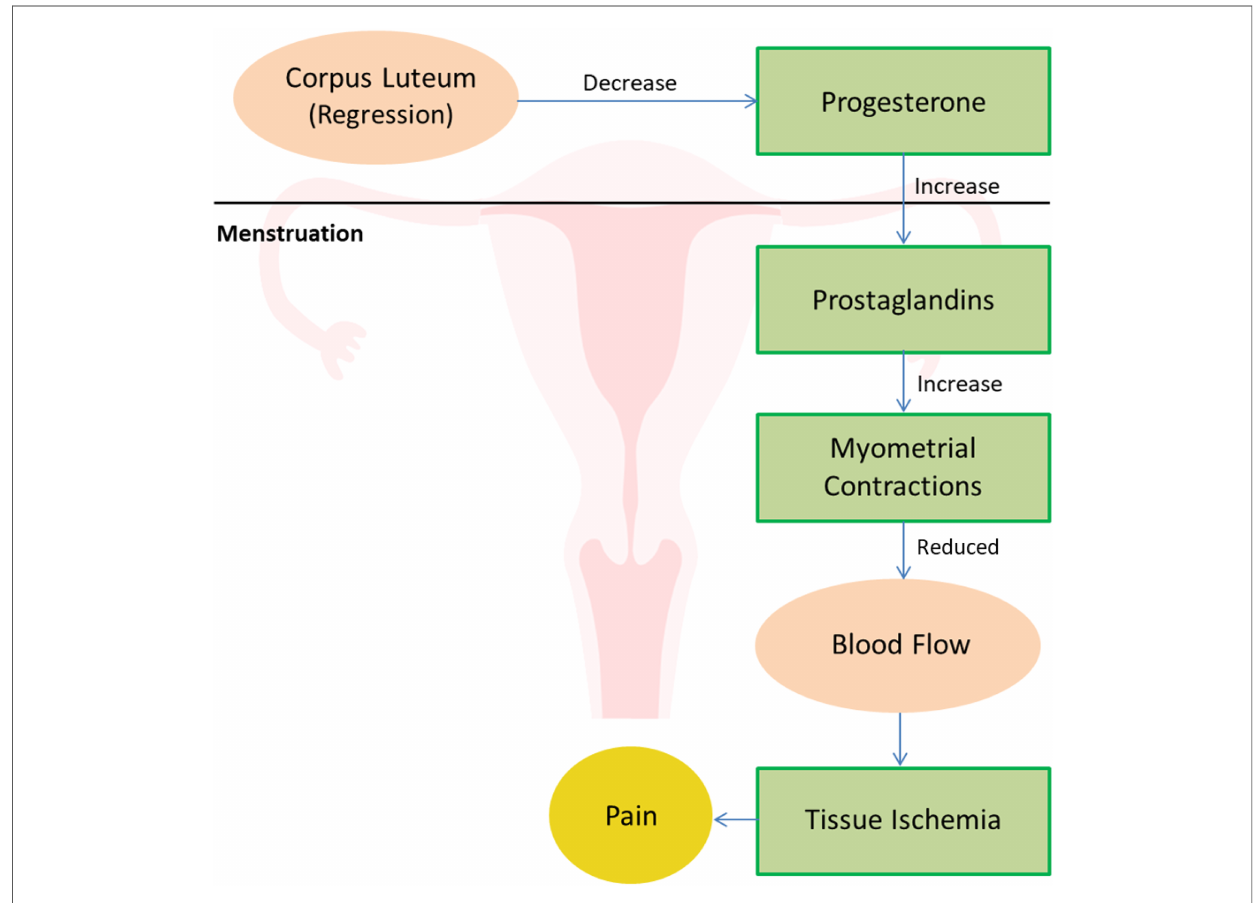
FIGURE 1 Physiology of